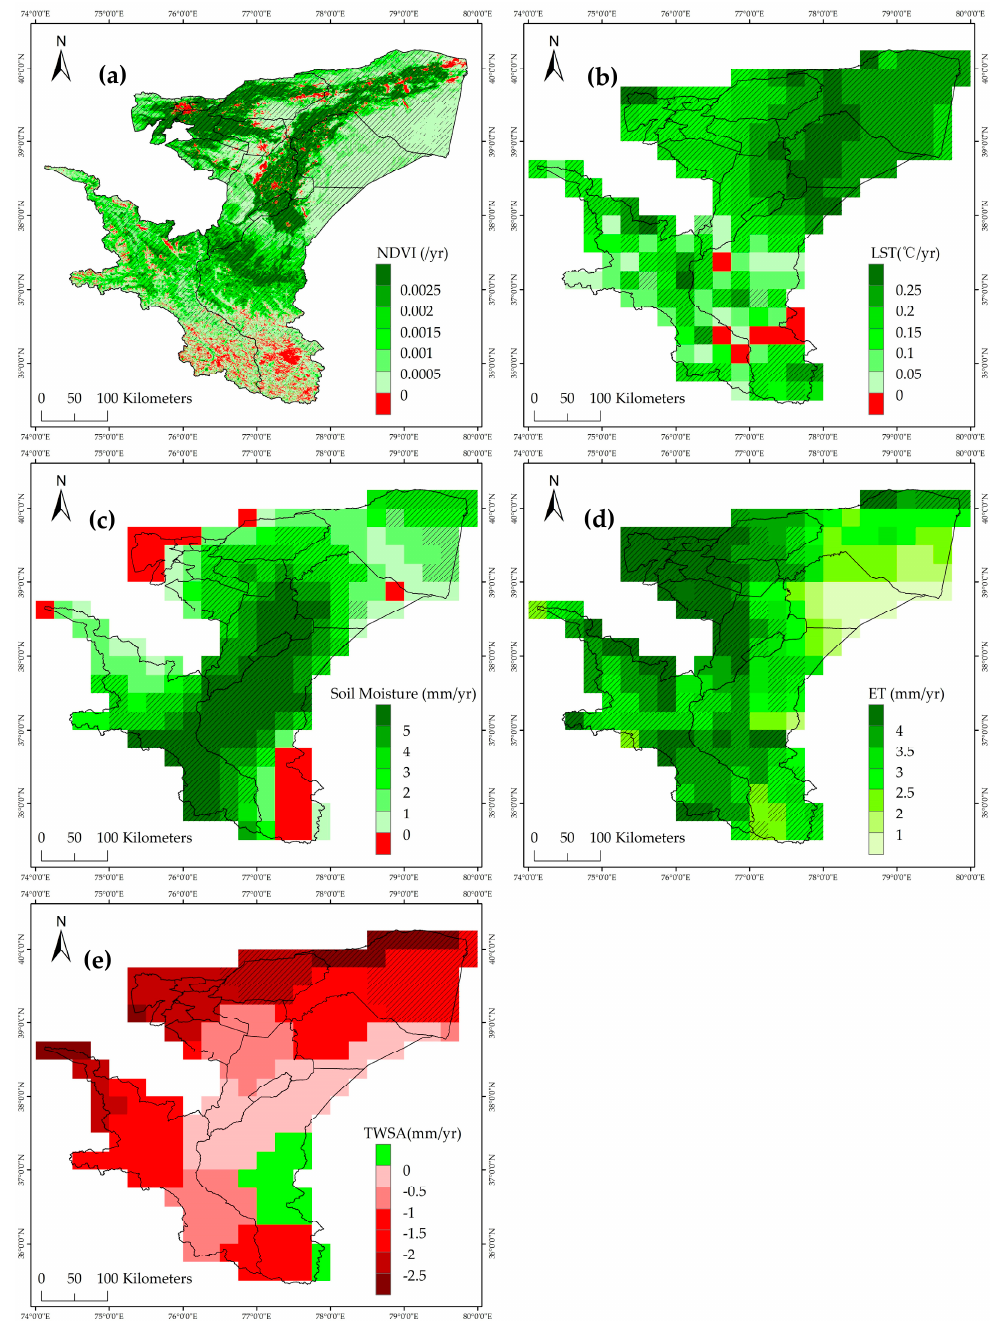
Figure 9. The spatial and temporal variation patterns of eco-hydrological parameters in the study area, normalized difference vegetation index (NDVI) ( a ), land surface temperature (LST) ( b ), soil moisture (SM) ( c ), evapotranspiration (ET) ( d ), and total water storage anomalies (TWSA) ( e ).